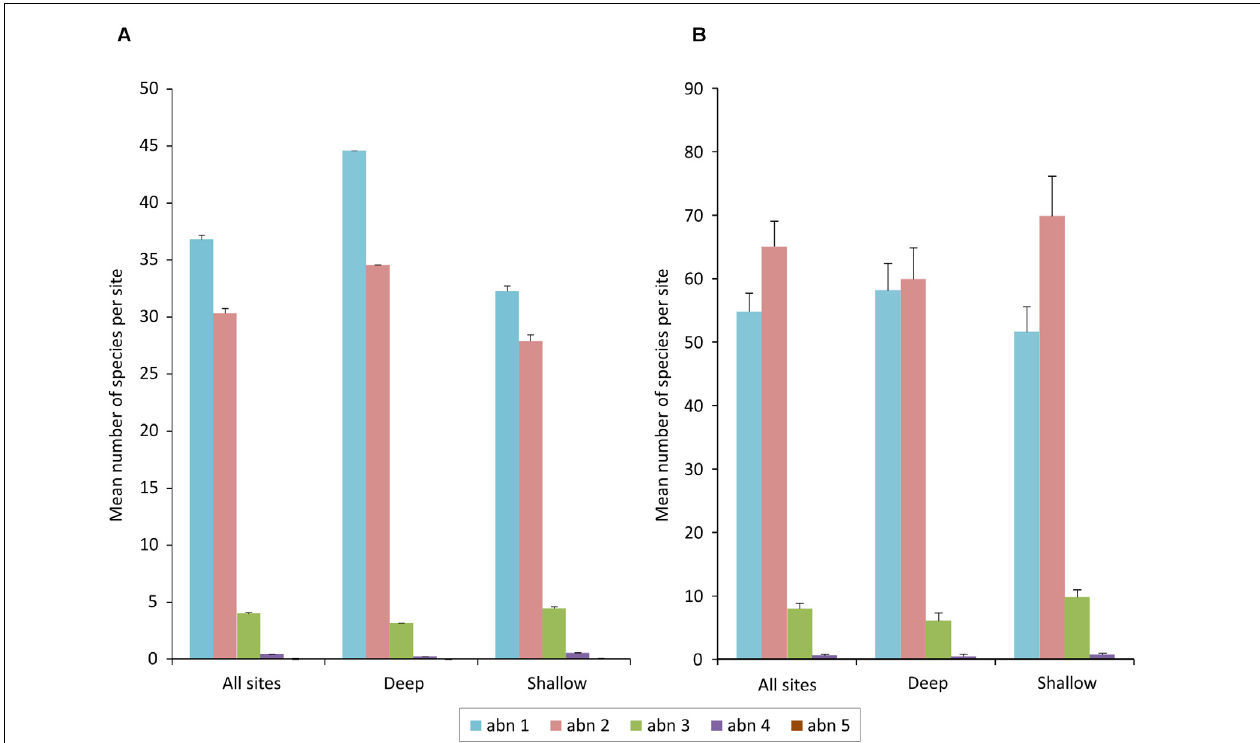
FIGURE 3 | Bar graphs of distribution of species abundances as mean numbers of species per site in each of five ranked abundance categories, with standard error: (A) for all sites, and (B) for richest